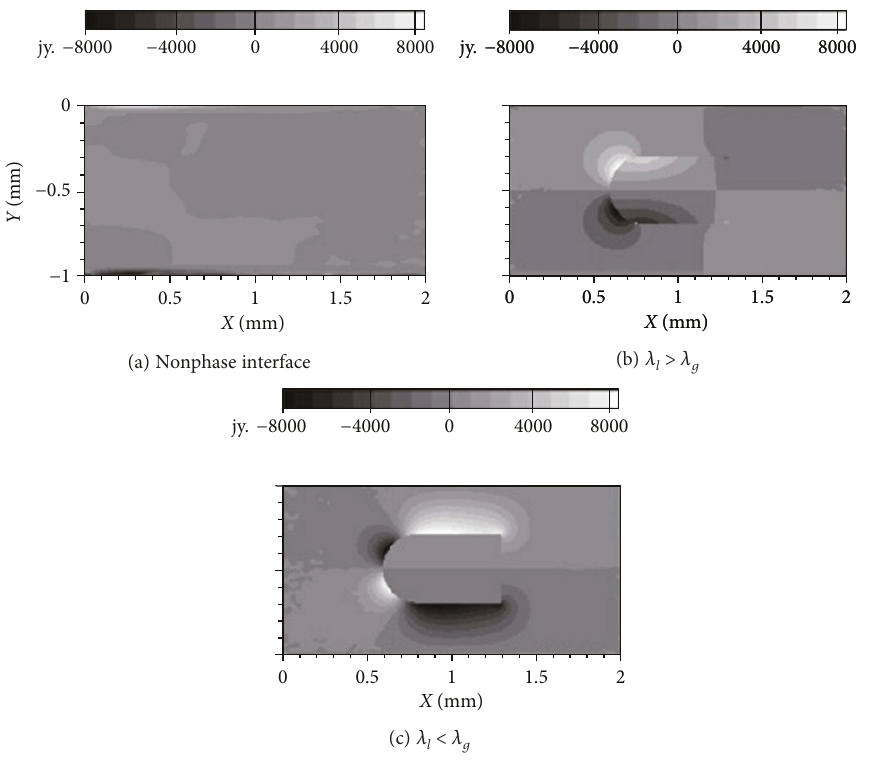
Figure 2: Temperature gradient diagram of Y direction with or without phase interface.